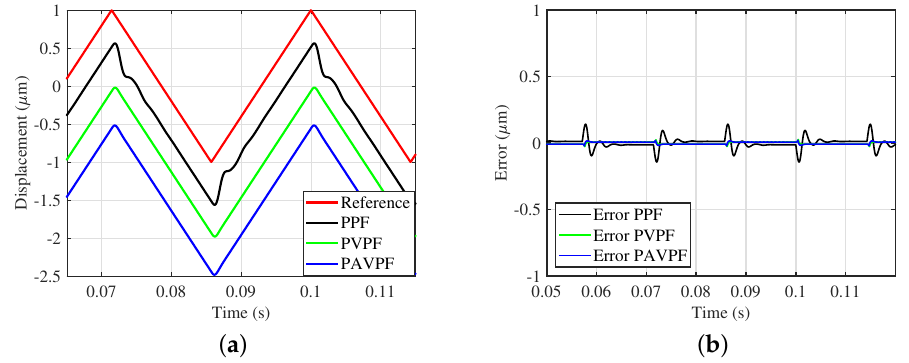
Figure 6. ( a ) Time domain traces by the proposed PPF, PVPF and PAVPF controllers for 35 Hz triangular wave input ; ( b ) Measured error by proposed PPF, PVPF and PAVPF controller for 35 Hz triangular wave